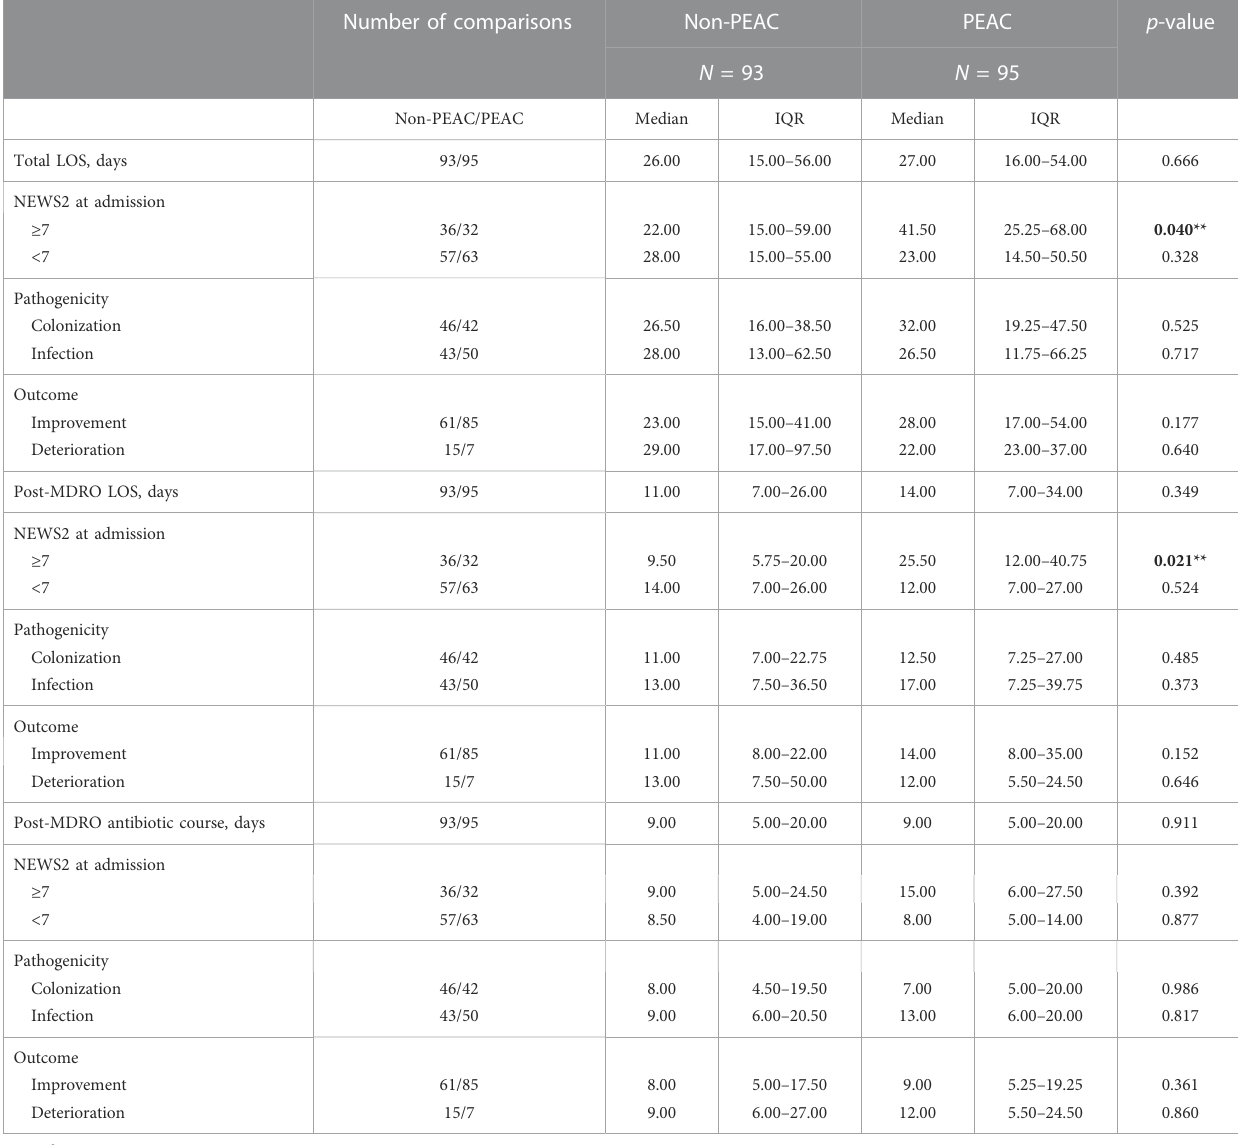
TABLE 3 Treatment duration of MDRO patients with or without PEAC. Number of